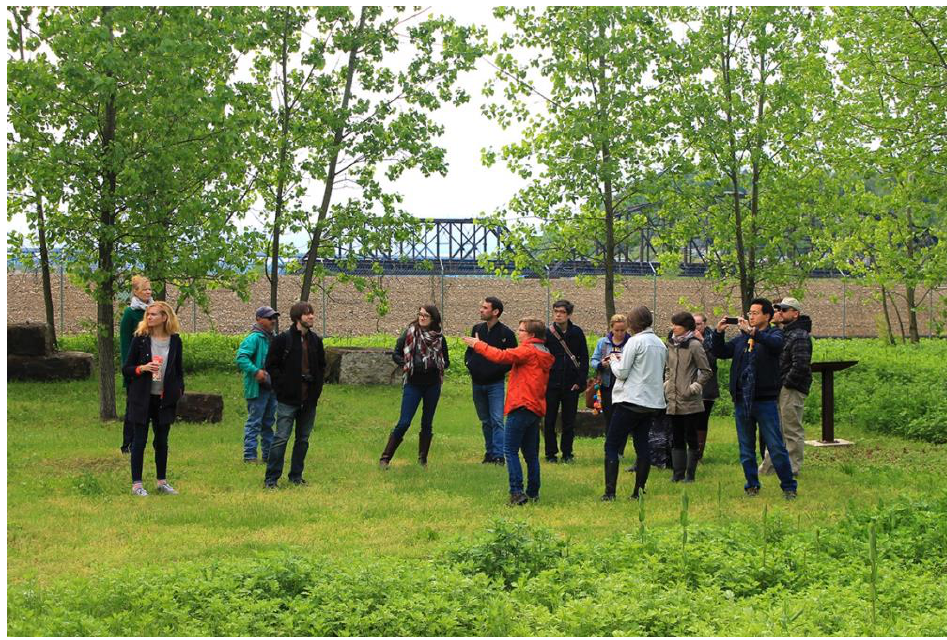
Consuming Nature workshop participants at Carrie Furnace, May 2017. (Photo: Ana Rodríquez